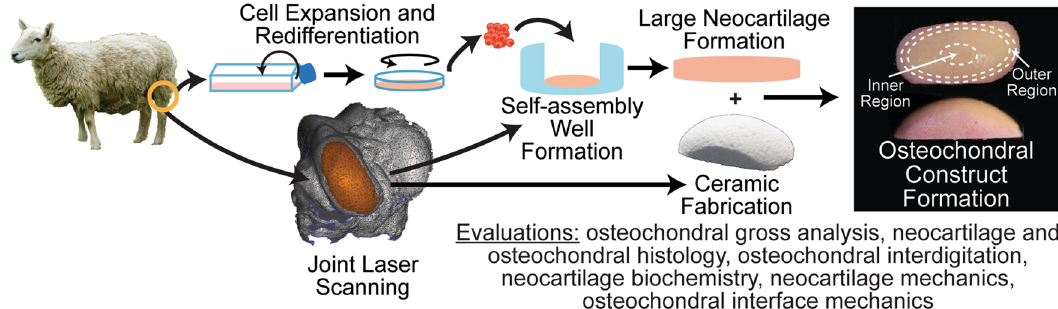
Fig. 1 Experimental overview. 3D scans of the medial femoral condyle of juvenile sheep were used to generate large, anatomically shaped neocartilage self-assembly wells and hydroxyapatite ceramics. Passage 4, redifferentiated juvenile ovine articular chondrocytes were used to generate scaffold-free neocartilage. At days 4 or 10 of neocartilage maturation, the neocartilage and ceramics were assembled to form osteochondral constructs. All evaluations took place at the end of the 35-day culture